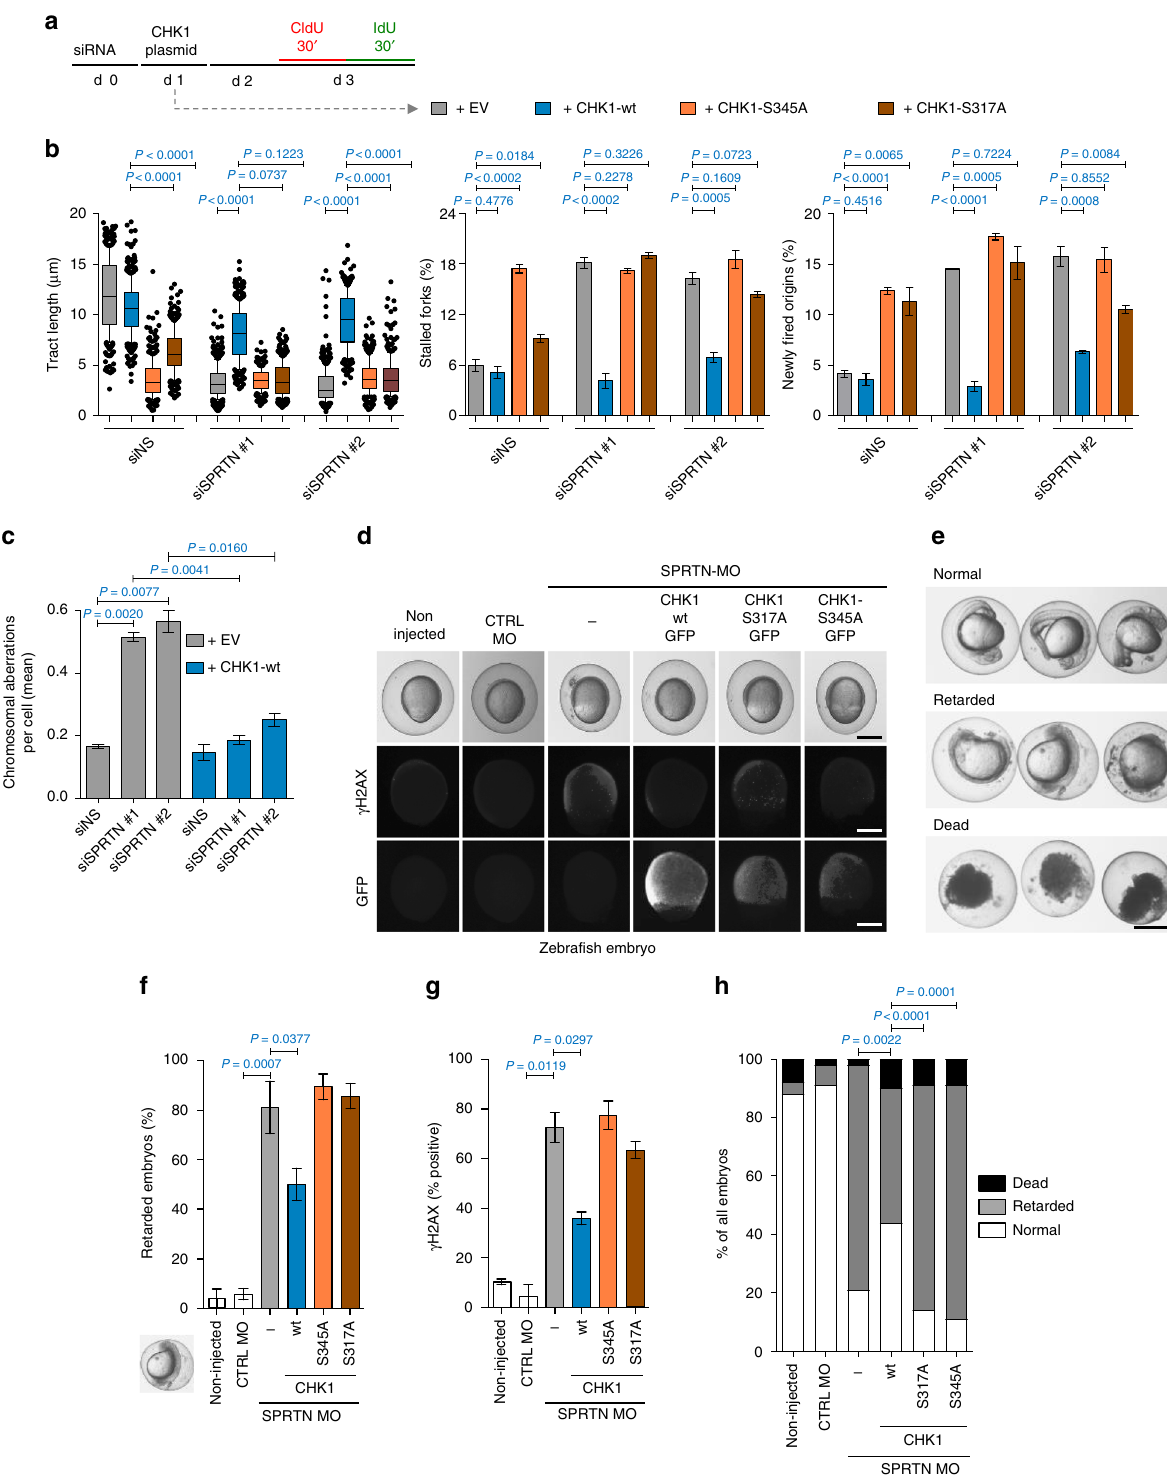
In addition, immuno fl uorescence-coupled microscopy analysis of ssDNA formation in S-phase cells (CldU positive) by BrdU staining under native conditions further suggested that SPRTN- defective cells do not form extensive ssDNA (Fig. 3d – f), a platform for canonical and robust ATR-CHK1 activation. Similar results were obtained with FA-treatment. HU or Camptothecin (CPT) treatment was used as a positive control for